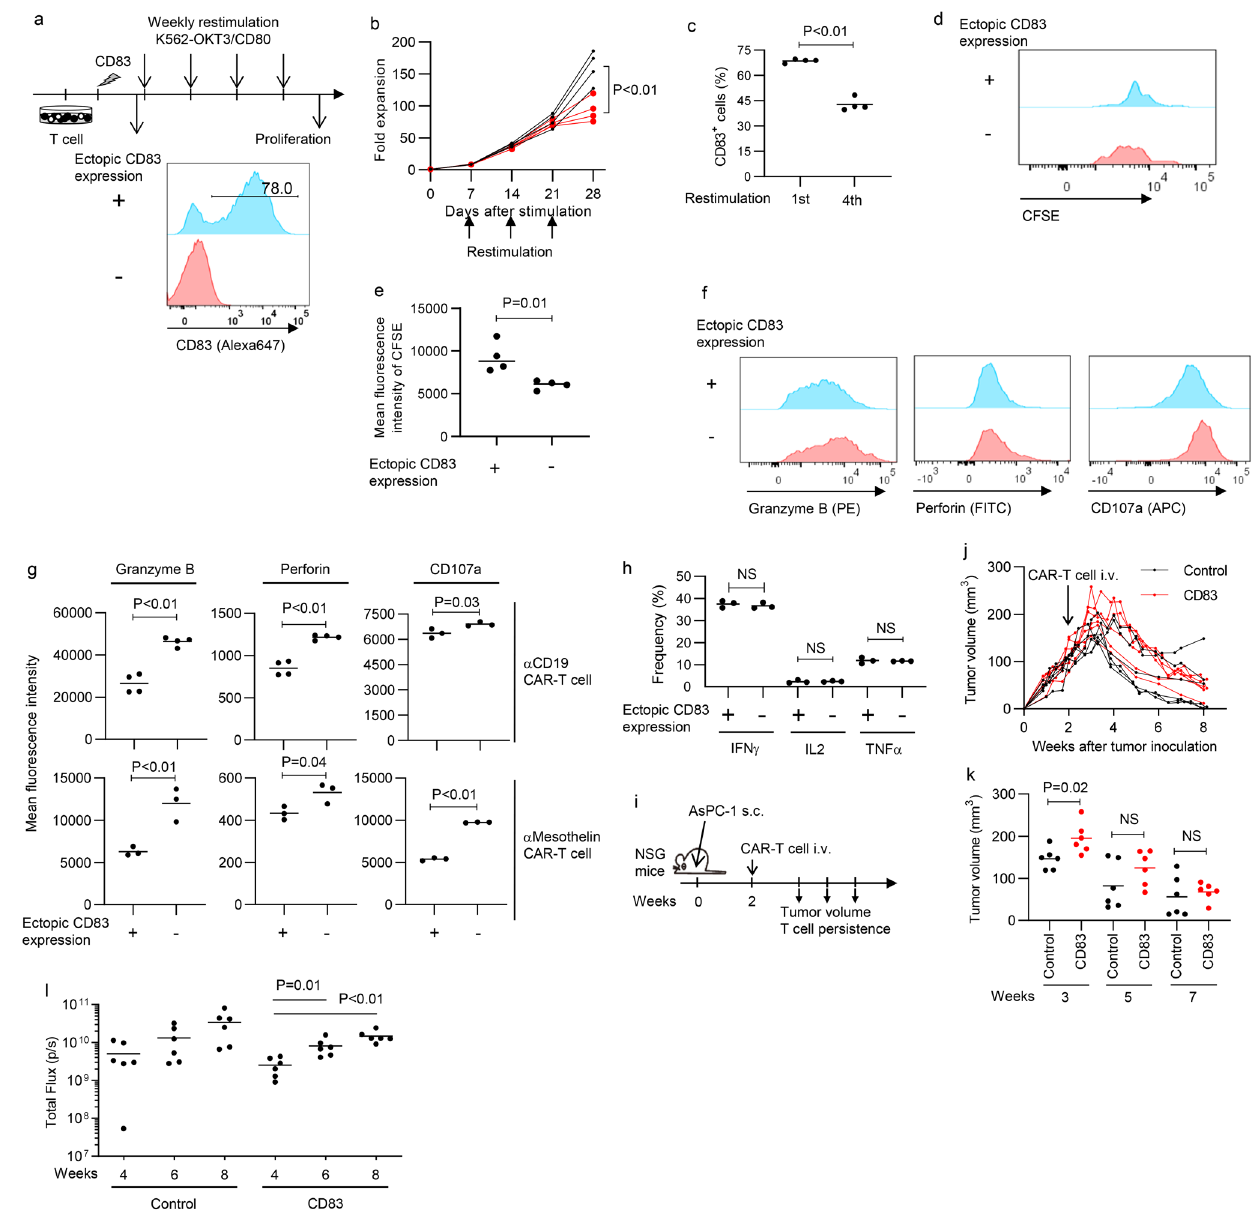
Fig. 5 CD83 expression negatively affects CD8 + T-cell effector functions. a – c Human T cells were retrovirally transduced with CD83 and weekly restimulated by K562-mOKT3/CD80. b Fold expansion of T cells. Arrows indicate T cell stimulation by K562-mOKT3/CD80 ( n = 4 independent cultures, representative data of two experiments). c The frequency of CD83-transduced cells within the CD8 + T cell population was analyzed with fl ow cytometry after the 1st or 4th stimulation ( n = 4 independent cultures). d , e Control or CD83-overexpressing T cells were analyzed for CFSE dilution upon the 4th restimulation. Representative fl ow cytometry plots ( d ) and the mean fl uorescence intensity of CFSE 5 days after stimulation are shown ( e ), ( n = 4 independent cultures). f , g Control or CD83-overexpressing anti-CD19 or anti-mesothelin CAR-T cells were analyzed for production of granzyme B and perforin and CD107a expression upon restimulation by NALM6 or K562-mesothelin. Representative fl ow cytometry plots for anti-mesothelin CAR-T cells ( f ) and mean fl uorescence intensity are shown ( g ), ( n = 3-4 independent cultures). h CD19-targeting CAR-T cells with or without ectopic expression of CD83 were analyzed for cytokine production upon restimulation by NALM6 ( n = 3 independent cultures). i NSG mice subcutaneously transplanted with the mesothelin + pancreatic cancer cell line AsPC-1 were treated by control or CD83-overexpressing CAR-T cells against mesothelin. CAR-T cells were cotransduced with the luciferase gene to monitor in vivo persistence. j , k Tumor volume was longitudinally monitored ( n = 6 mice for each). l Total fl ux of the luciferase activity was analyzed by in vivo bioluminescent imaging ( n = 6 mice, repeated measures one-way ANOVA with multiple comparison test for the log-transformed values). The data presented in ( j – l ) are a composite of three independent experiments. In ( b , c , e , g , h , and k ), statistical signi fi cance was analyzed by unpaired two-tailed t -test. NS not signi fi